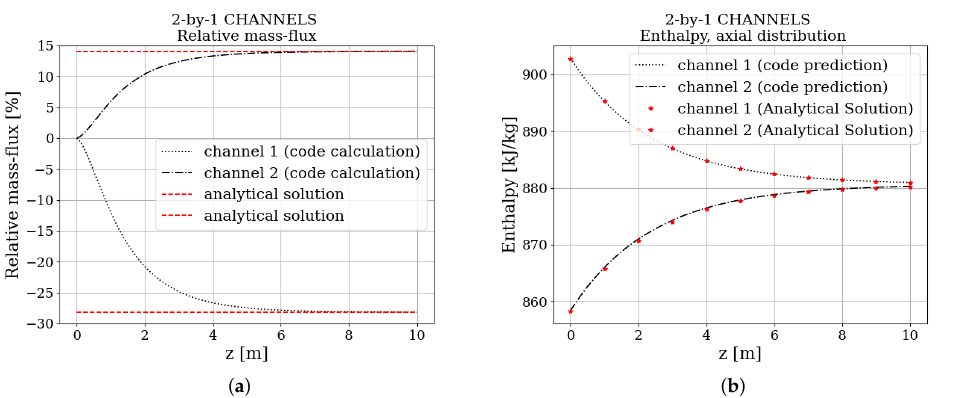
Figure 6. Verification Results. ( a ) Relative mass flow distribution in the axial direction. ( b ) Enthalpy distribution in the axial